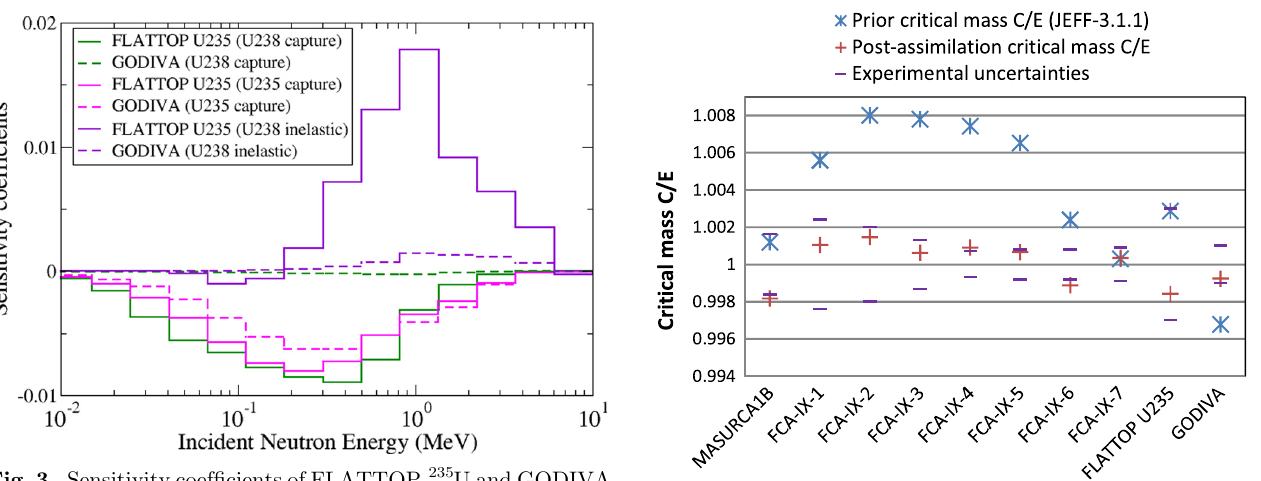
Fig. 3. Sensitivity coef fi cients of FLATTOP- 235 U and GODIVA critical masses to 235 U capture and 238 U inelastic and capture cross sections.